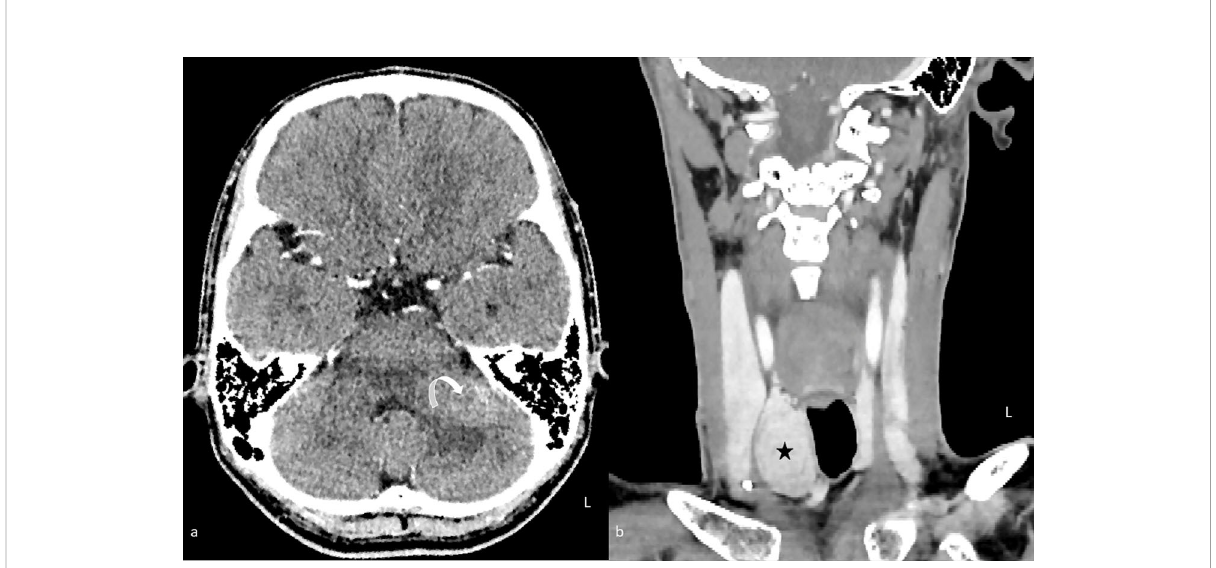
FIGURE 1 Contrast-enhanced computed tomography of the brain (A) in axial plane and neck (B) in coronal plane. An enhancing lesion in the left middle cerebellar peduncle is causing mass effect with mild effacement of the fourth ventricle (curved arrow). A right thyroid nodule is also seen synchronously